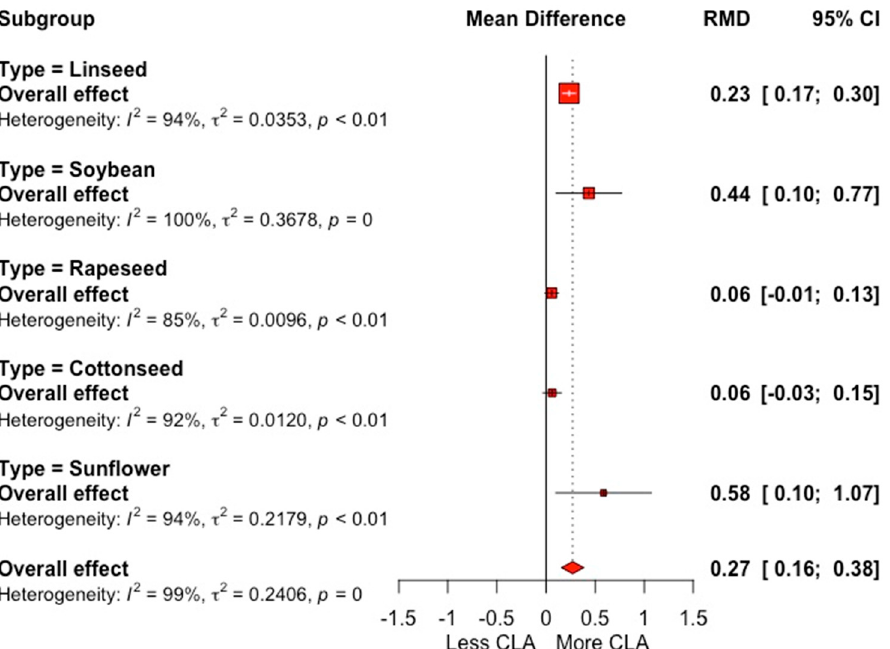
Figure 4. Forest plot of conjugated linoleic acid (CLA; g 100 g − 1 FA) for trials with the inclusion of oilseeds in dairy cow diets, grouped by type of oilseed. Point size reflects the relative weighting of the study to the overall effect size estimated, where a larger point size represents a greater weight and the combined effect size estimated, including the confidence interval. The diamond represents the overall effect. RMD, raw mean difference.